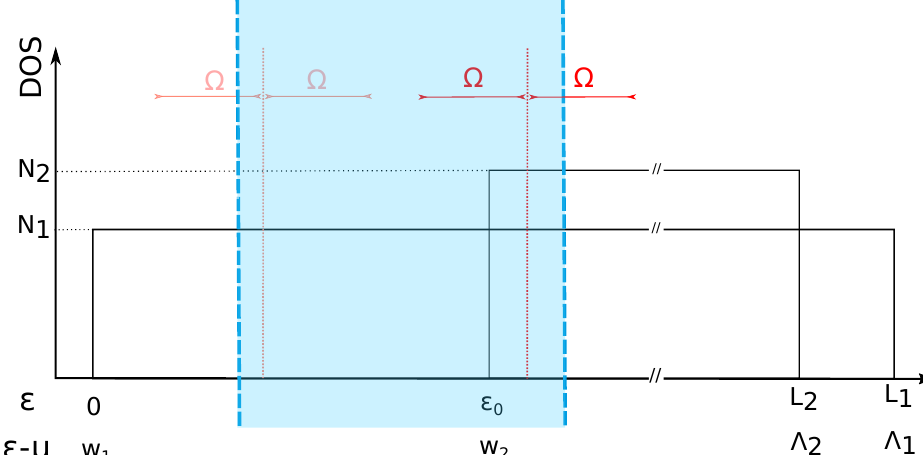
Figure 1. Sketch figure of the density of states (DOS) N 1 and N 2 as functions of the energy ε (reduced µ ) of the two-band system. The blue dashed lines highlight the observation window energy ξ = ε − of energy (reduced energy) accessible, so far, through experiments: according to the parameters involved in LAO/STO interfaces, the lower band is well described by the BCS theory, the pairing Ω lying entirely in the band, while the upper band stays in the so-called BEC window µ ±